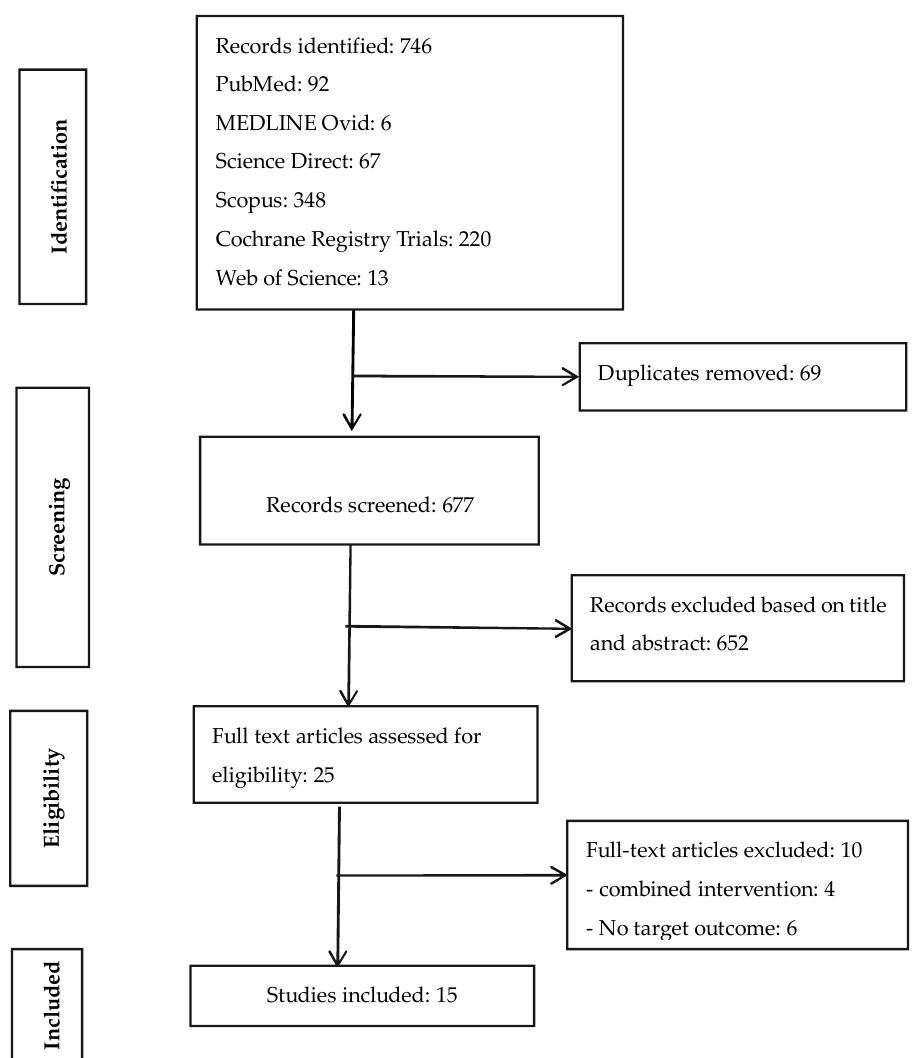
Figure 1. PRISMA flow chart of literature search. Electronic databases (Cochrane Library Trials (CENTRAL), MEDLINE—Ovid, PubMed, Science Direct, SCOPUS, and Web of Science) were searched for relevant records using appropriate search terms and filters (Table 1). The search stream was considered most appropriate after several ‘trial and error’ attempts. Analysis and synthesis of included records were done by two independent